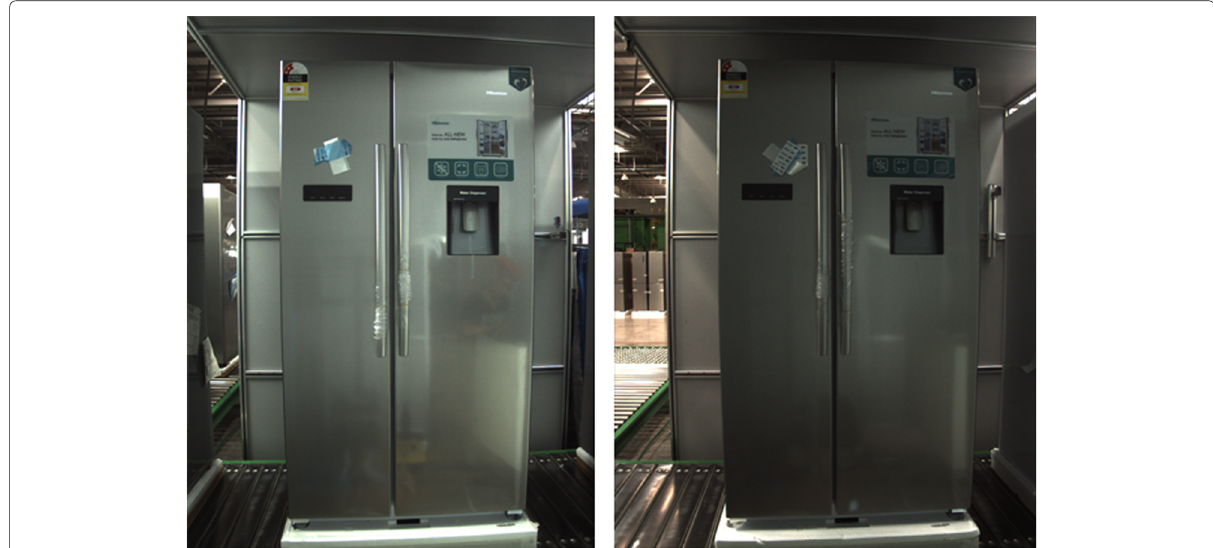
Fig. 4 The specular reflection in the front-view images of